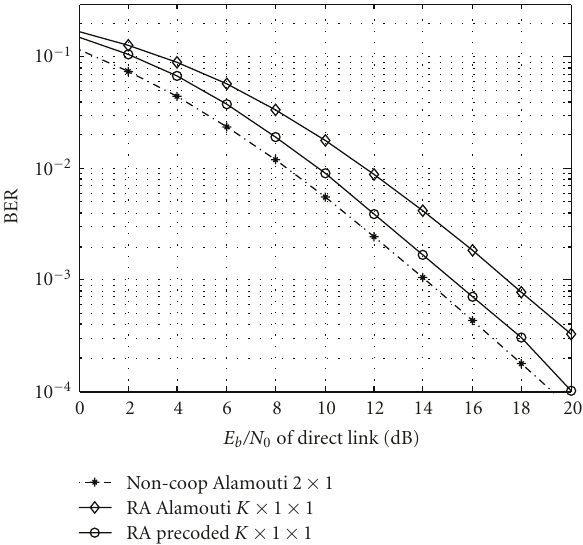
Figure 10: BER of cooperative systems with 1 antenna per relay and of reference systems for Scenario